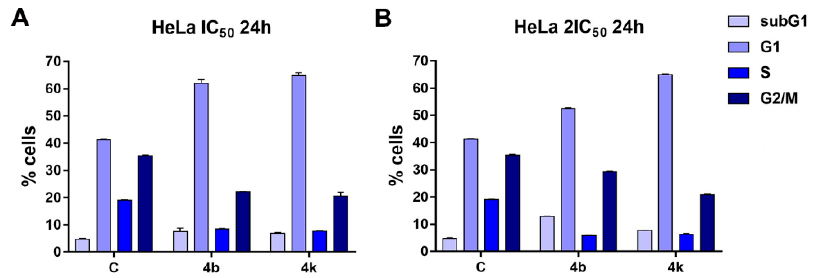
Figure 4. Cell-cycle phase distribution of control HeLa cells and HeLa cells incubated with IC 50 ( A ) and 2 IC 50 ( B ) concentrations of compounds 4b and 4k during 24 h. The data shown represent the average ± standard deviation of two independent experiments.